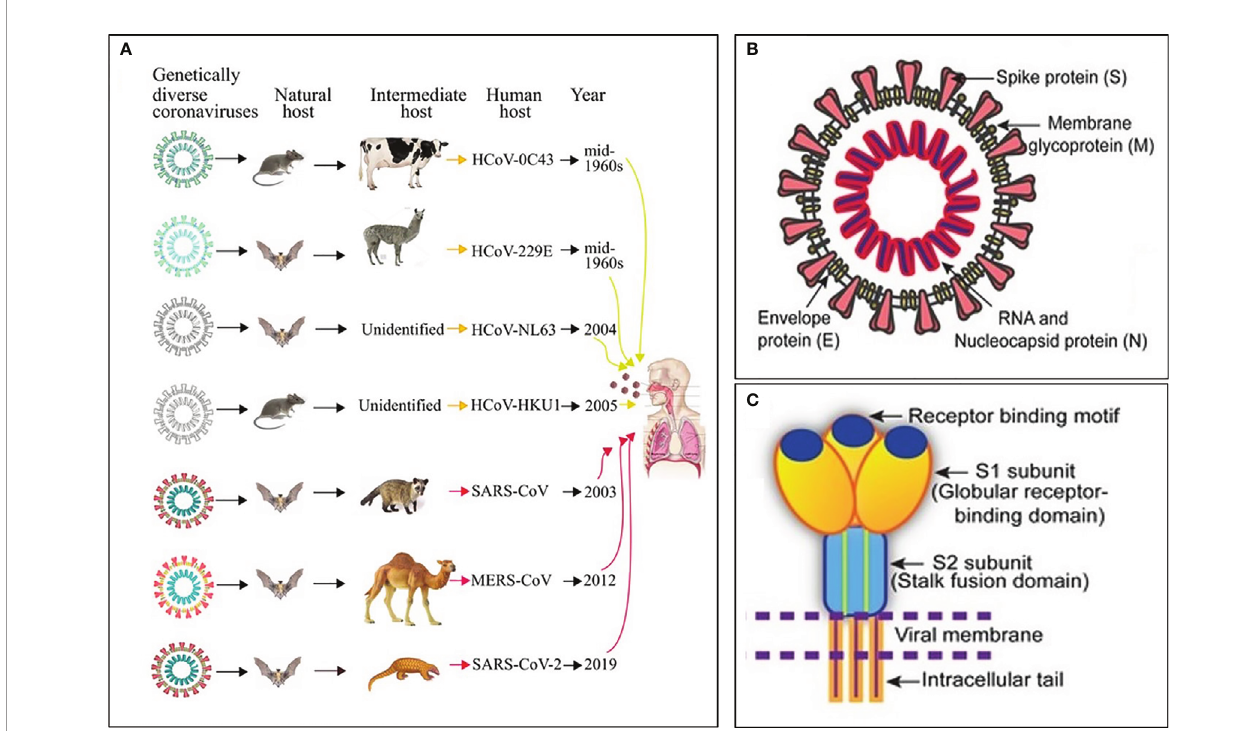
FIGURE 1 | Origin, transmission and structure of pathogenic human coronaviruses (HCoVs). (A) Yellow and red arrows represent mild and severe infections in humans, respectively. (B) Schematic diagram of the SARS-CoV structure. (C) Cartoon showing key features and the trimeric structure of the SARS-CoV-2 S protein. Modi fi ed from Mittal et al.,